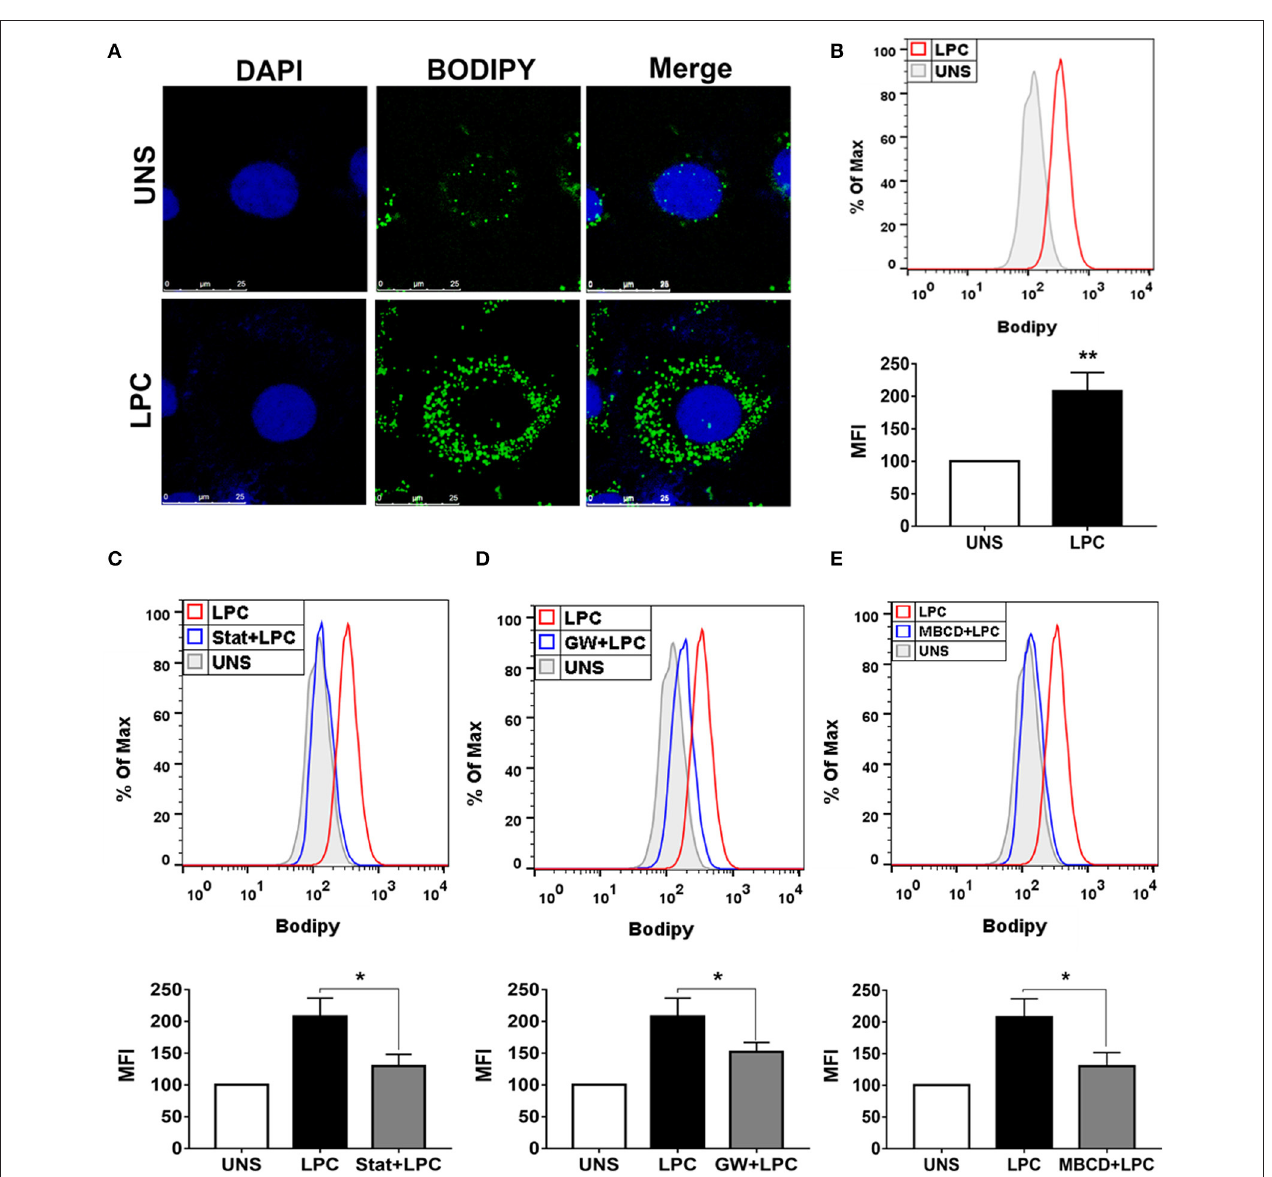
FIGURE 2 | Lysophosphatidylcholine (LPC) induces foam cell formation in human endothelial cells through mechanisms dependent on HMG-CoA reductase, PPAR- γ , and lipid rafts. (A) Human endothelial cells were stimulated with 1 µ g/ml of LPC, and after 24h, lipid droplets were stained with the fluorescent probe BODIPY (green), and the nucleus was labeled with DAPI (blue). Images were taken by confocal microscopy. Scale bar, 25 µ m. (B) Human endothelial cells were pretreated with (C) inhibitor of HMG-CoA reductase (statin—stat), (D) antagonist of PPAR- γ [GW9662 (GW)], and (E) destabilizer of lipids rafts [methyl- β -cyclodextrin (MBCD)] for 1h and stimulated with 1 µ g/ml of LPC for 24h. Lipid droplets were stained with BODIPY and analyzed by flow cytometry. Histograms are representatives of three independent experiments. Each bar graphic represents the mean fluorescence intensity (MFI), and each bar graphic represents the mean fluorescence intensity (MFI), and bars show significant differences and represent the 95% confidence interval (* p < 0.05 and ** p < 0.01) of the cells stimulated with LPC or UNS (unstimulated cells).